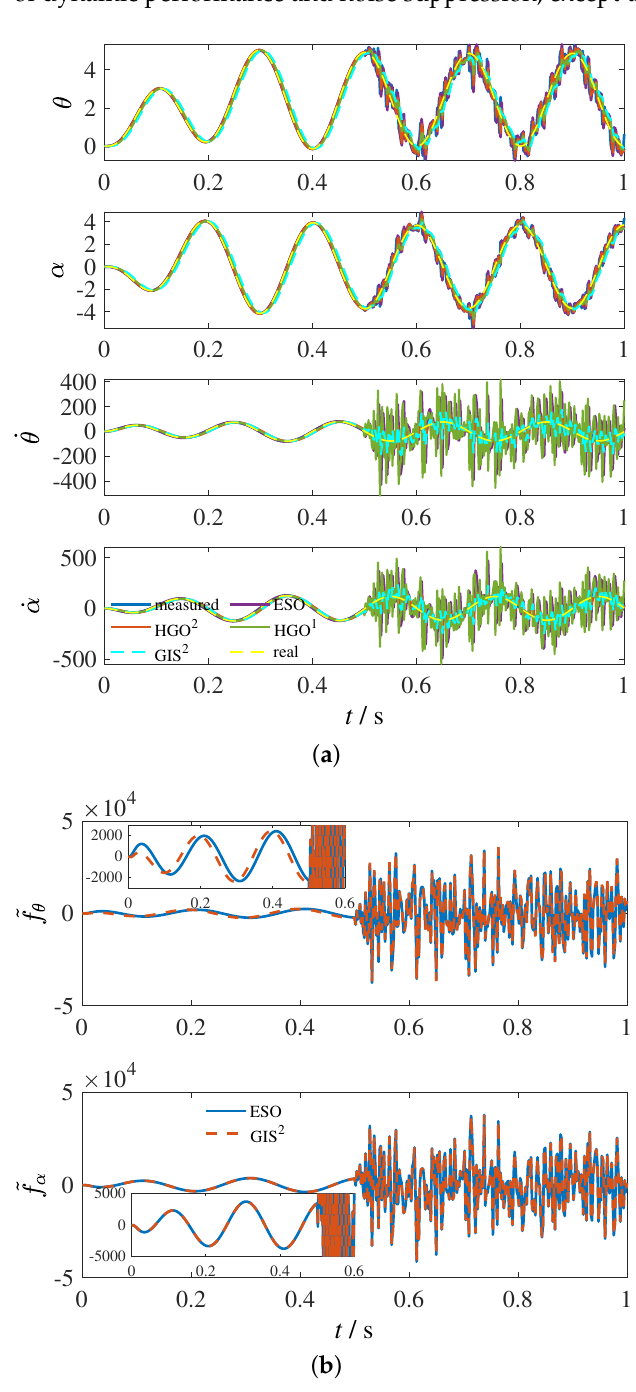
Figure 5. Estimated states of model-free observers: ( a ) derivatives; ( b )